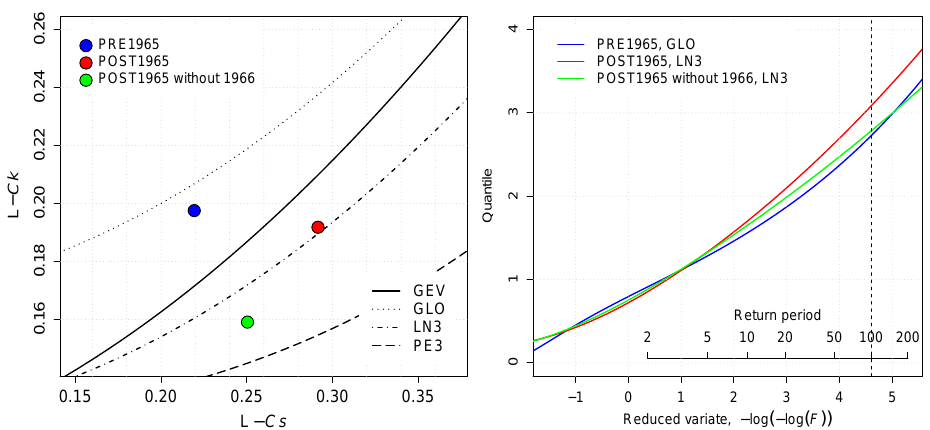
Figure 4. Left: L-moment ratio diagram for three-parameter distributions. Blue, red and green points represent the record length weighted average of L-Cv and L-Cs in Triveneto for PRE1965, POST1965 and POST1965 without 1966 sub-samples, in this order. Right: dimension- less growth-curves associated with the above mentioned three sub-samples. The choice of the corresponding three-parameter distribution was made by applying Hosking and Wallis test (see Hosking and Wallis,